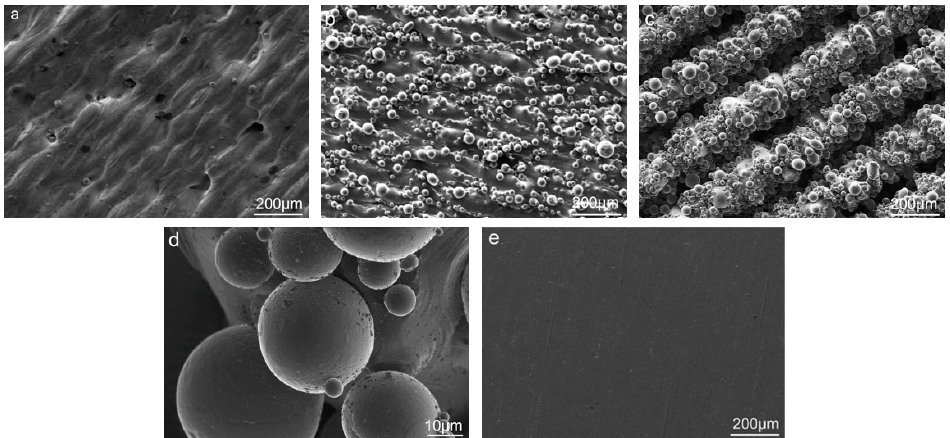
Figure 1. SEM images of three typical surface topographies: ( a ) stripy structure (S), ( b ) bulbous structure (B), and ( c ) bulbous–stripy composite surface (BS); ( d ) high-resolution images of BS microstructures; and ( e ) topography of Ti substrate (control).